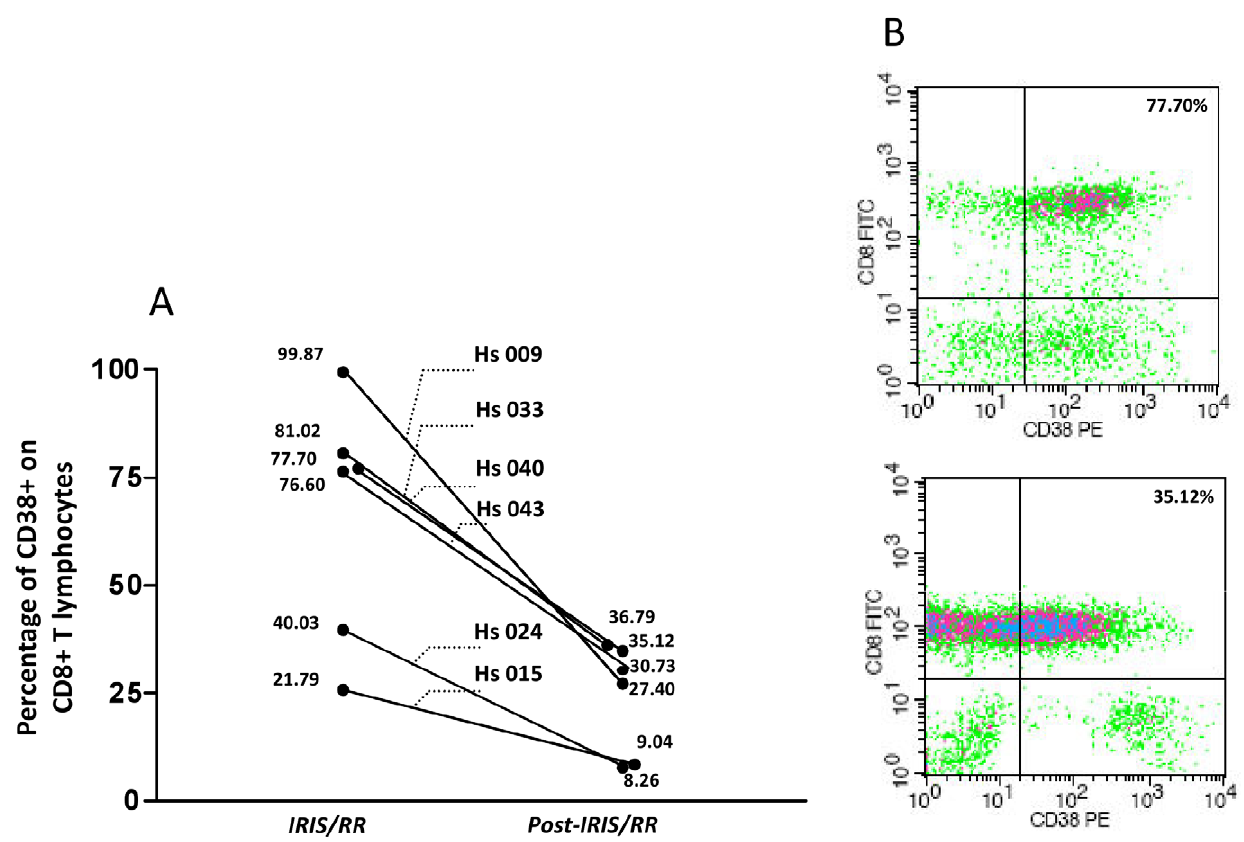
Figure 2. The percentage of CD38 + in CD8 + T lymphocytes obtained from HIV/leprosy-coinfected patients during the development of immune reconstitution inflammatory syndrome/reversal reaction (IRIS/RR) episodes and at the completion of reaction treatment with prednisone (Post-IRIS/RR) (Panel A). * p , 0.05 – Wilcoxon U test. Representative flow cytometry profile presented by one HIV/leprosy coinfected patient (Hs040), during an IRIS/RR episode (upper dot plot) and post-IRIS/RR (under dot plot) evaluated for the expression of CD38 in CD8 + T lymphocytes (Panel B).